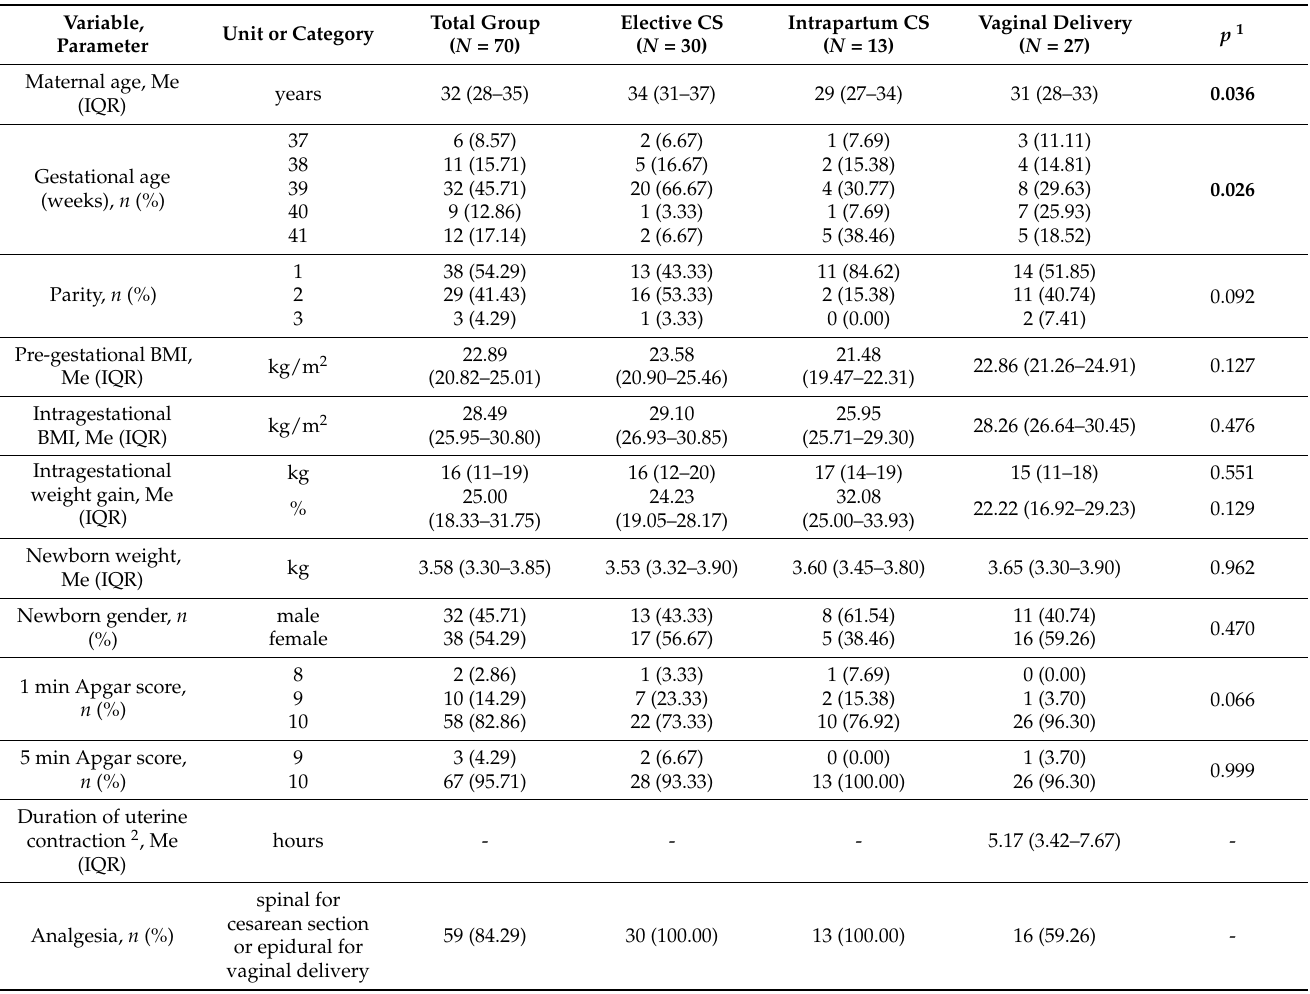
Table 1. Study group clinical